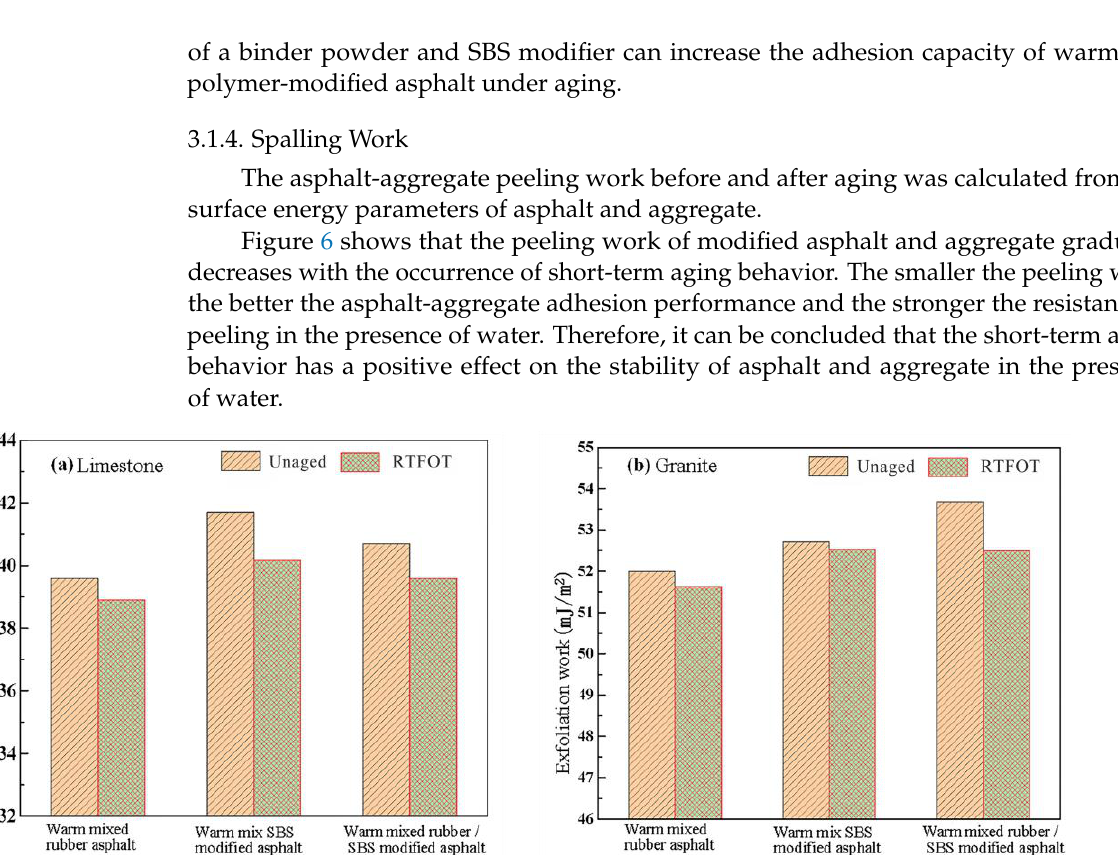
10 of 14 Figure 5. Adhesion work of asphalt and different aggregates before and after aging: ( a ) Limestone and ( b ) Granite. From Figure 5, it can be seen that the change in adhesion power of the three modi- fied asphalts is basically the same for the same aggregate. After short-term aging, the adhesion power of both types of aggregates and asphalt increased. This suggests that short-term aging contributes to improving the asphalt-aggregate interface ’ s ability to